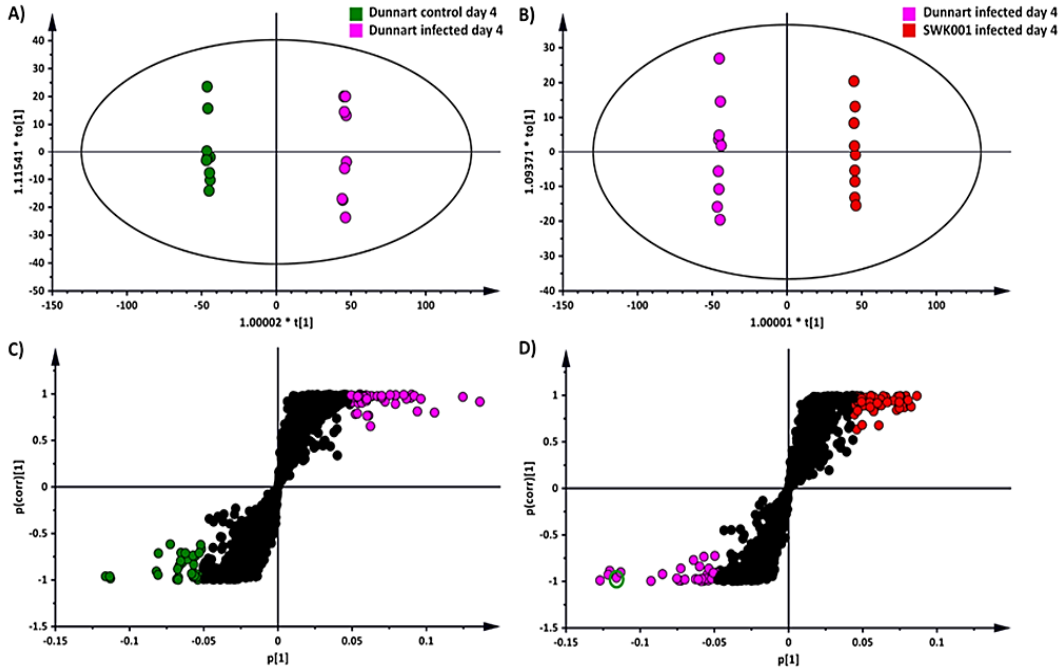
Figure 4. An OPLS-DA model of the two infected cultivars: “ Dunnart ” and “ SWK001 ” . ( A ) An OPLS-DA scores plot summarising the relationship among different datasets to visualise group clustering between the control and infected “ Dunnart ” groups at 4 d.p.i. based on their leaf-ex- tracted metabolic profiles obtained in ESI( – ) MS mode (R 2 = 0.999, Q 2 = 0.995, CV-ANOVA p -value = 1.89349 × 10 − 15 ). ( B ) OPLS-DA scores plot illustrating the relationship among the infected “ SWK001 ” and “ Dunnart ” plants at 4 d.p.i. based on their leaf-extracted metabolic profiles obtained in ESI(−) MS mode ( R 2 = 0.999, Q 2 = 0.996, CV-ANOVA p -value = 1.06365 × 10 −14 ). ( C ) The correspond- ing OPLS-DA loadings S-plot of ( A ). The pink and green circles indicate the values situated far out [1] ( p > 0.05, < −0.05 and p (corr) >0.5, < −0.5) in the S -plot, representing statistically significant ions that are possible discriminatory variables between the control and infected “ Dunnart ” groups. ( D ) The corresponding OPLS-DA loadings S-plot of ( B ). The pink and red circles indicate the values situated far out [1] ( p > 0.05, < −0.05 and p (corr) >0.5, < −0.5) in the S -plot, indicating statistically sig- nificant ions that are possible discriminatory variables between the infected “ SWK001 ” and “ Dun- nart ” plants. The green circle indicates the selected variable (avenanthramide A) for which valida- tion models are shown in Figure 5.